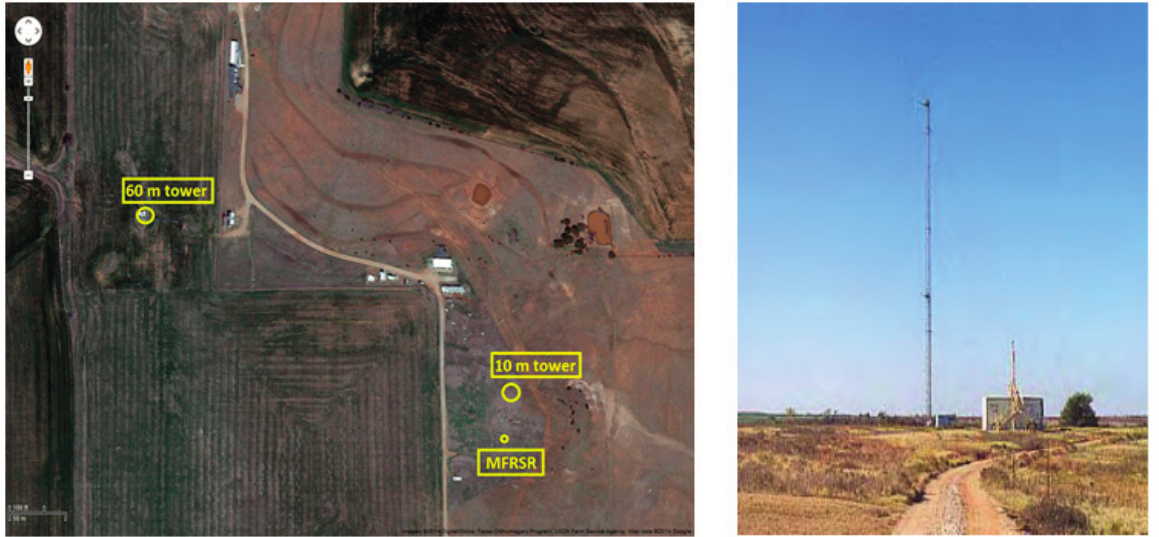
Figure 1. Aerial image of the Southern Great Plains (SGP) site ( left , taken from Google maps on 7 May 2014) and ground-based image of 60-m tower ( right , from [35]). The aerial image (about 1 × 1 km 2 ) indicates the locations of the ground-based Multi-Filter Rotating Shadowband Radiometer (MFRSR) and the two towers (60-m and 10-m) with downward- and upward-looking Multi-Filter Radiometers (MFRs). Also, the image illustrates that these towers are located within sub-areas with different surface types.